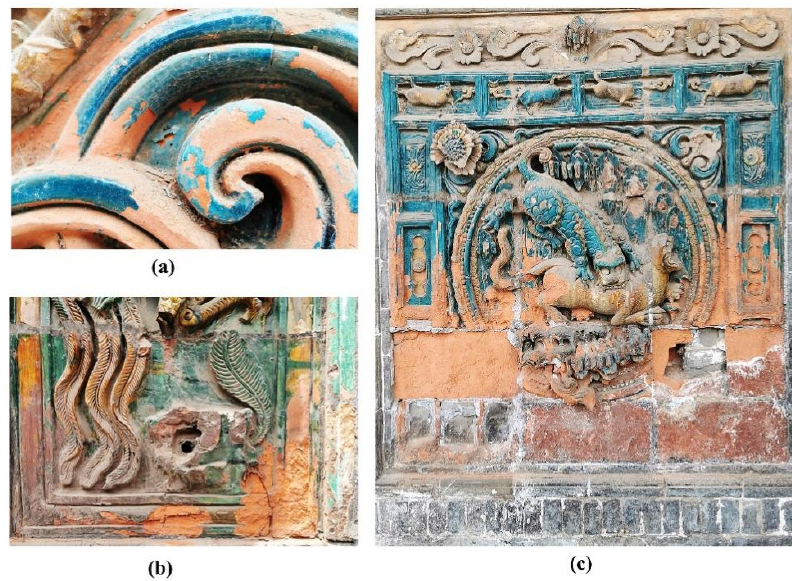
Figure 9. Decay images. ( a , b ) Glaze cracking and shedding; ( c ) Body salt efflorescence.